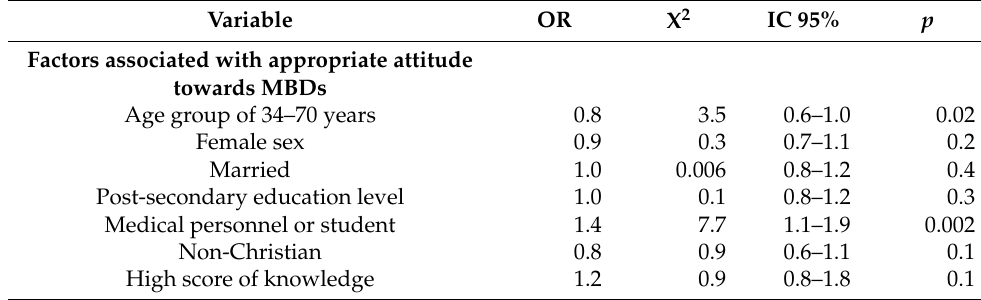
Table 9. Characteristics of participants associated with appropriate attitudes towards mosquitoes and mosquito-borne diseases (MBDs) in Kinshasa,